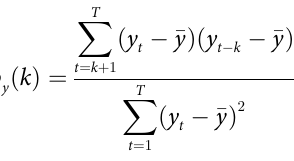
ffiffiffiffiffiffiffiffiffiffiffiffiffiffiffiffiffiffiffiffiffiffiffi P ð y (cid:0) � y Þ 2 t